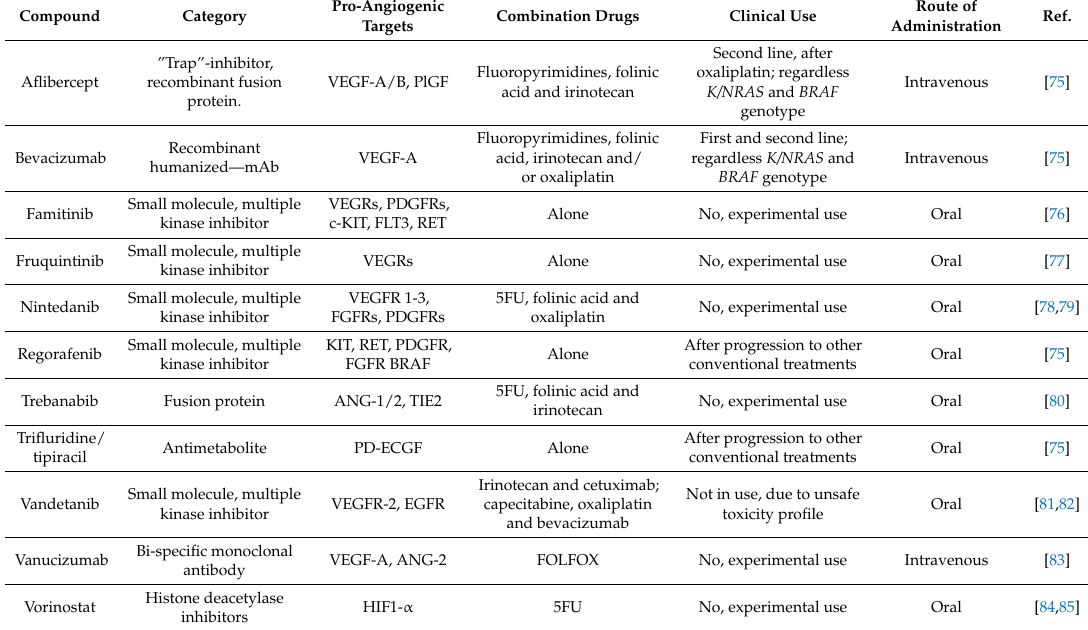
Table 1. Anti-angiogenesis drugs approved for metastatic CRC and recent clinical trials with potential new anti-angiogenesis